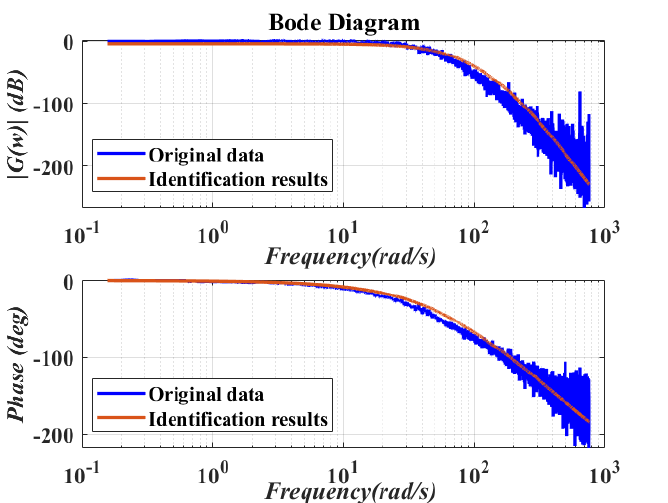
Figure 3. Frequency responses obtained by original data and identification